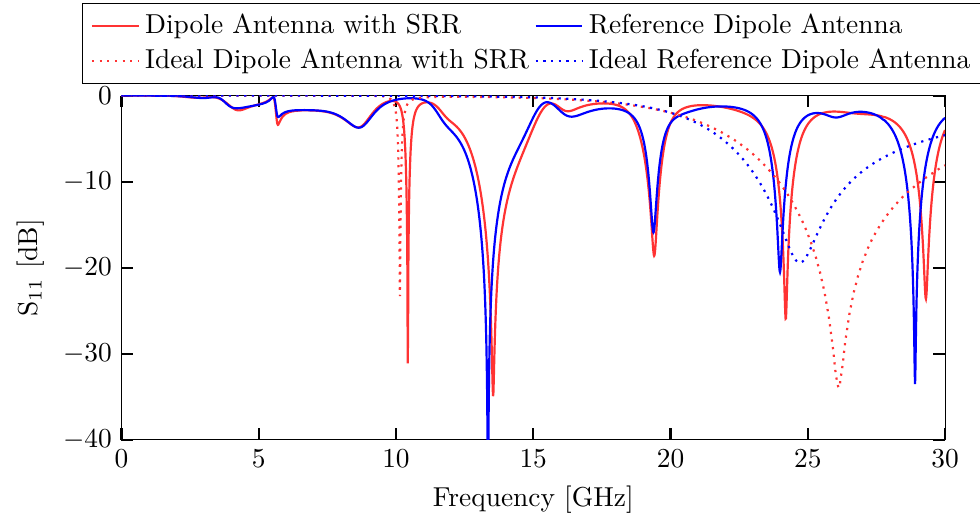
Figure 2. Simulated S 11 -amplitudes of a dipole antenna with split-ring resonator (SRR) and a reference dipole antenna without SRR, accounting for the feed line and SMA connector (red and blue solid lines, respectively). The ideal dipole antenna with SRR and ideal reference dipole antenna (red and blue dotted lines) display the S 11 -amplitudes, when the feed line and SMA connector are